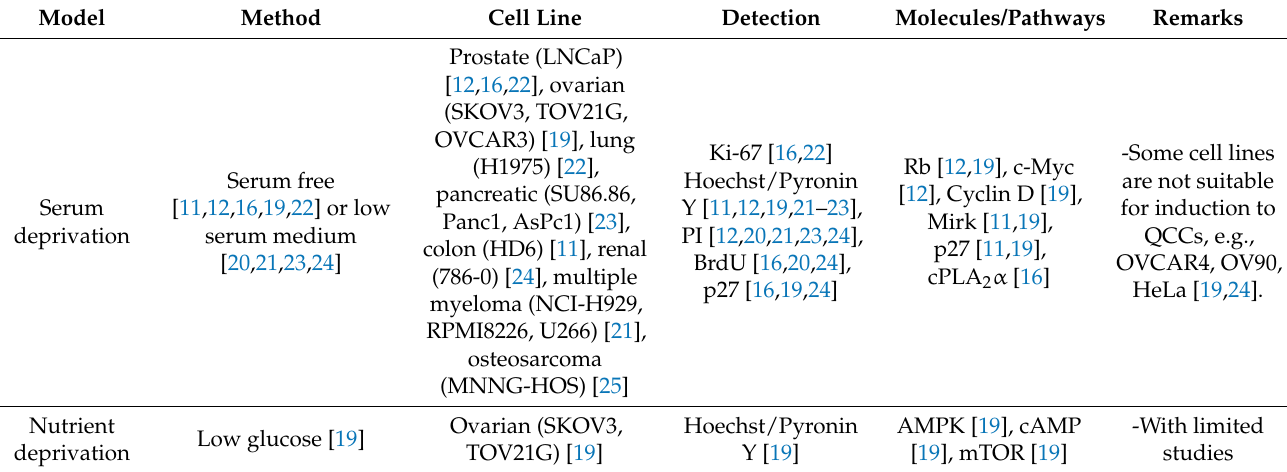
Table 1. Overview of the model and method of quiescent cancer cell studies.